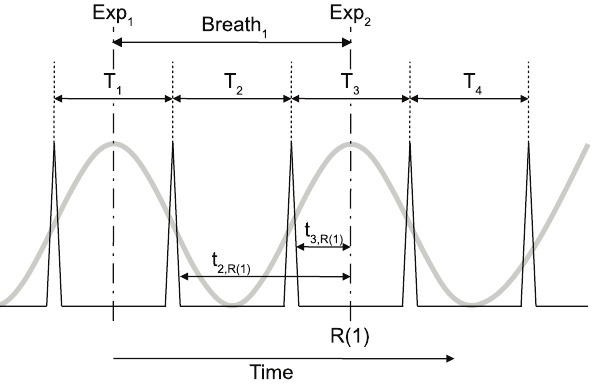
Figure 2. Assessment of the relative phase between breathing and cycling for a 1/2 ratio. The grey curve represents the respiration signal (Exp i corresponds to the beginning of the expiration i) and the black peaks represent the pedalling strikes. t i , R ( p ) represents the distance from the pedaling strike i to the end of the p respiratory cycle. T i represents the period of the pedalling strike i